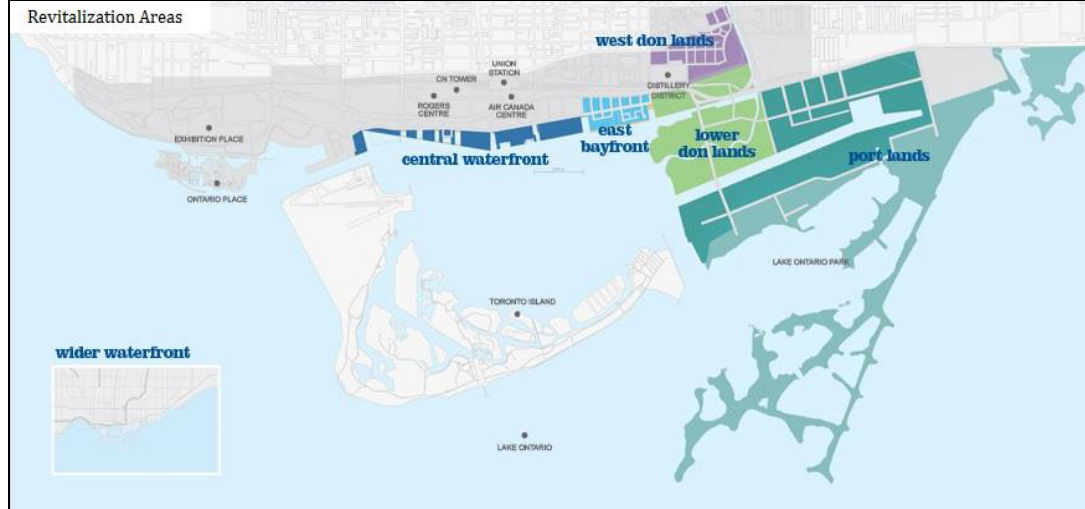
Figure 1 .Map of Waterfront Toronto Communities. Source: Waterfront Toronto (n.d.-a).